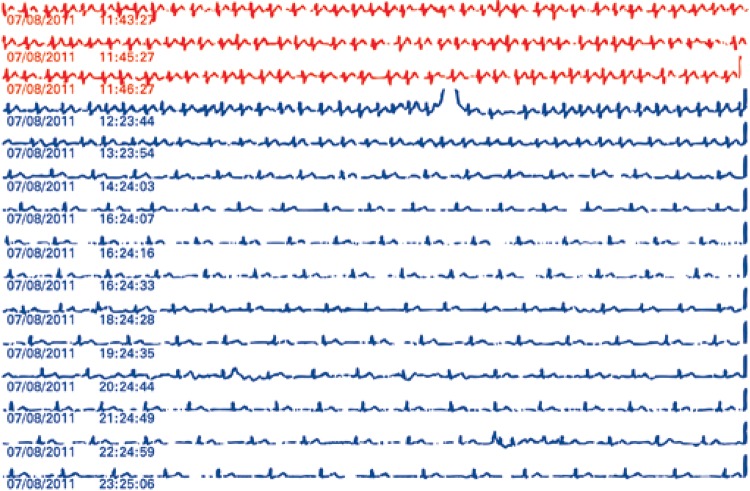
Traçado do web-loop durante sintoma palpitação (diagnóstico de fibrilação atrial) em homem 57 anos. O traçado em vermelho representa registro do sintoma em uma derivação eletrocardiográfica no momento do acionamento do sistema (duração 45 segundos). O traçado em azul são as emissões automáticas e periódicas do eletrocardiograma em uma derivação (duração 15 segundos cada)